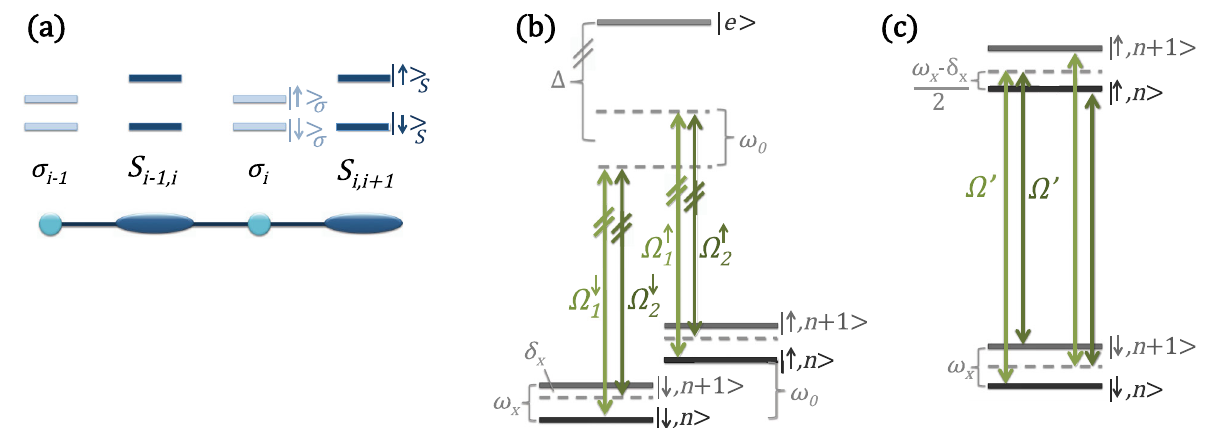
FIG. 3. Proposed experimental scheme. (a) Two kinds of pseudospins encode matter and gauge fields in an alternating fashion, with and S . The corresponding internal states are labeled as j #i , j "i and j #i , j "i , respectively. (b) and associated spin matrices (cid:5) i i;i þ 1 (cid:5) (cid:5) S S (c) Spin interactions of zz type are transmitted by coupling the pseudospin levels (sketched for a single ion) to phonons. (b) For hyperfine qubits, one can engineer these couplings via a differential light shift induced by two pairs of Raman beams (with Rabi and detuning j (cid:2) j (cid:6) ! ; here ! is the qubit energy difference, with (cid:1) ¼ (cid:5) , S ). The Raman transition is detuned by frequencies (cid:3) " ; # (cid:1) (cid:1) 1 ; 2 (cid:8) from the phonon frequency ! . j n i denotes the phonon-number Fock state. (c) For optical qubits, one can use two beams with Rabi x x ¼ (cid:3) ¼ (cid:3) 0 that are tuned (with a small detuning (cid:8) ) close to half the phonon frequency ! frequencies (cid:3) x x 1 2